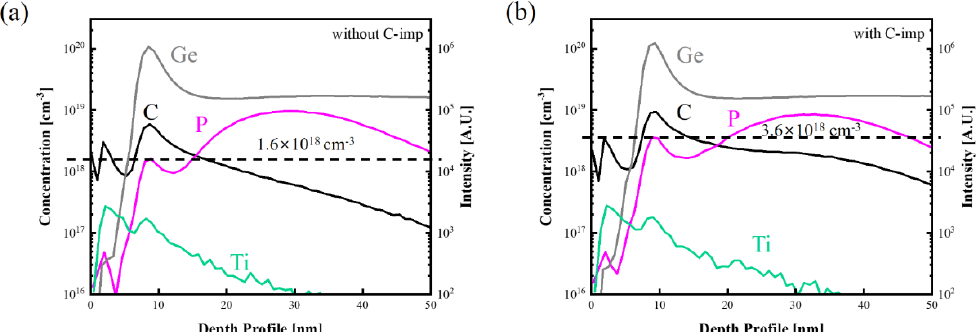
Figure 5. SIMS profiles for Ti/Ge contacts ( a ) without and ( b ) with C-imp after RTA at 600 °C. With C-imp, a dopant (phosphorous) segregation at the Ti/Ge interface is clearly observed.